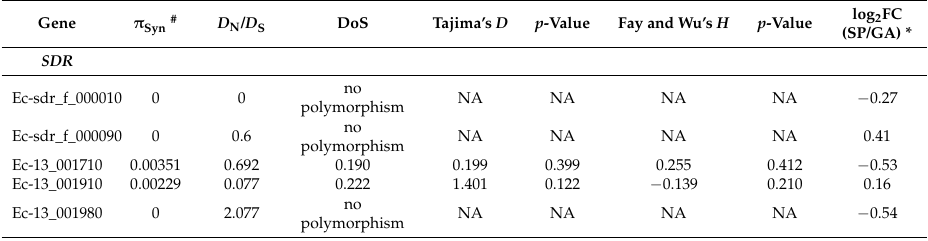
Table 2 and Figure 4 summarize the diversity statistics for all genes, based on synonymous